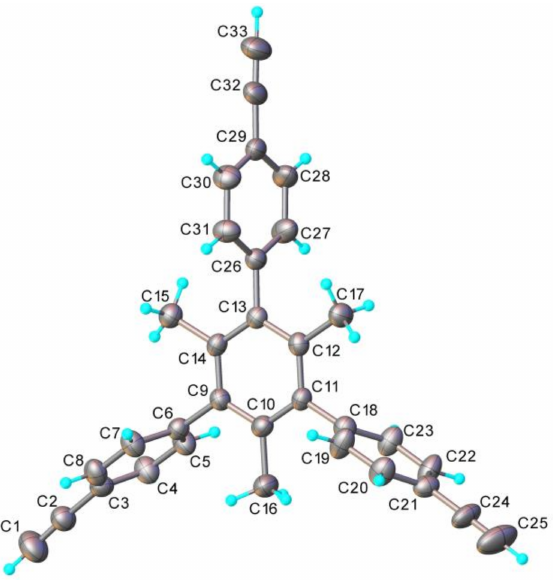
Figure 3. X-ray molecular structure of 10 with atom labeling and thermal ellipsoids at 40%